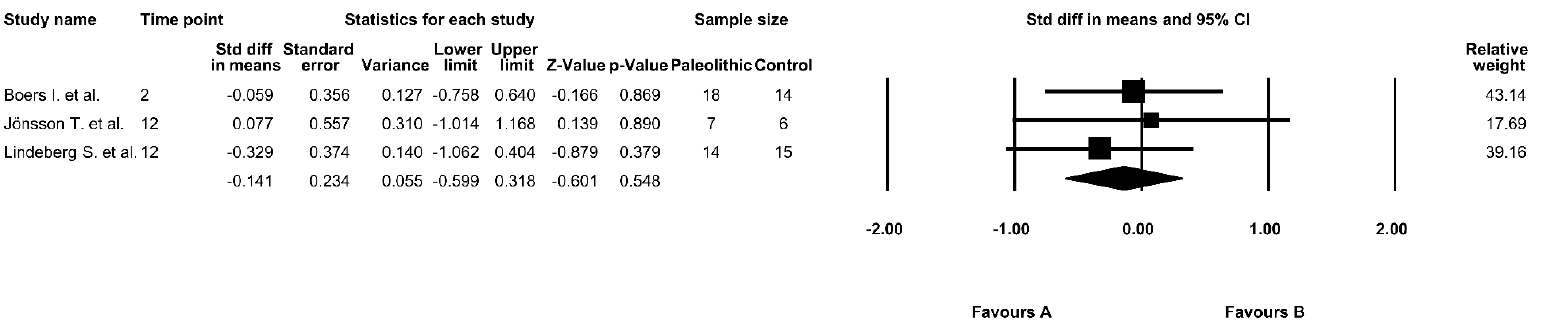
Figure 3. Forest plot comparing fasting insulin levels between the diets (favors A—Paleo group; favors B—control group).